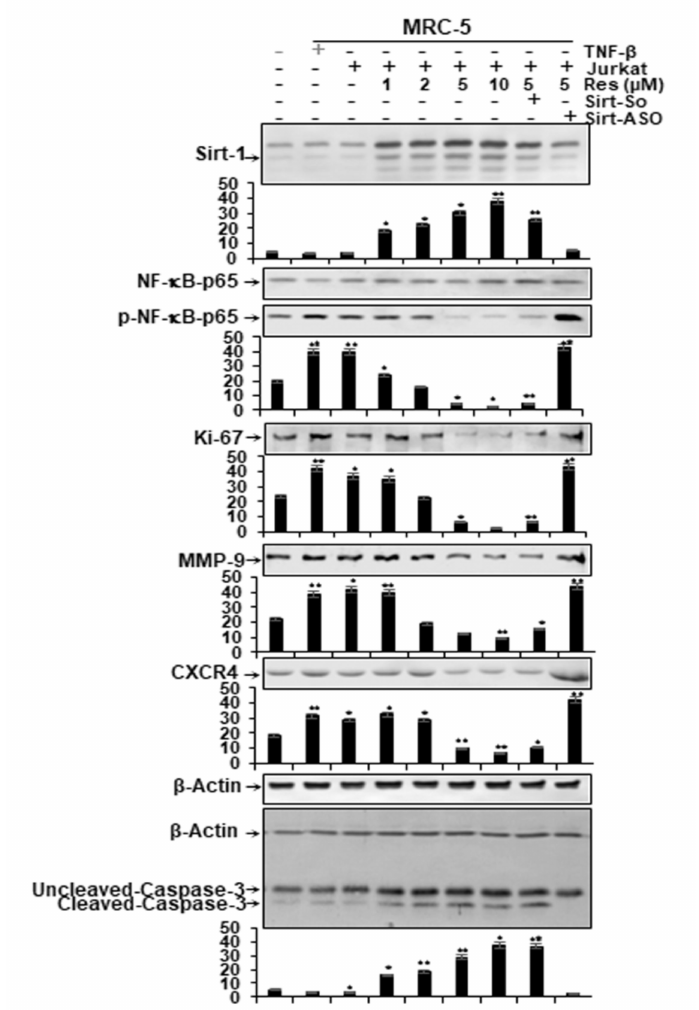
Figure 5. Impact of resveratrol and Sirt1-ASO on Sirt1 expression, stimulation of NF- κ B and NF- κ B-promoted gene end-products in CRC cells in the multicellular-TME. Serum-starved cultures of HCT116 cells in 3D alginate cultures alone (basal control = co) or co-cultured with fibroblasts and TNF- β (10 ng / mL) (TNF- β -TME) or co-cultured with fibroblasts and T-lymphocytes (pro-inflammatory multicellular-TME) were either left untreated, or multicellular-TME cultures were treated with various doses of resveratrol (1, 2, 5, 10 µ M), or transfected with 0.5 µ M sense oligonucleotide (SO) control, or antisense oligonucleotides (ASO) against Sirt1 in the presence of Lipofectin transfection reagent (10 µ L / mL) and co-treated with resveratrol (5 µ M) for 14 days in alginate cultures, as described in the Materials and Methods section. Whole cell lysates were prepared and analyzed by Western blotting with antibodies against Sirt, p65-NF- κ B, phospho-p65-NF- κ B, MMP-9, CXCR4, Ki67 and cleaved-caspase-3. β -actin served as an internal loading control in all experiments. * p < 0.05, ** p < 0.01 relative to basal